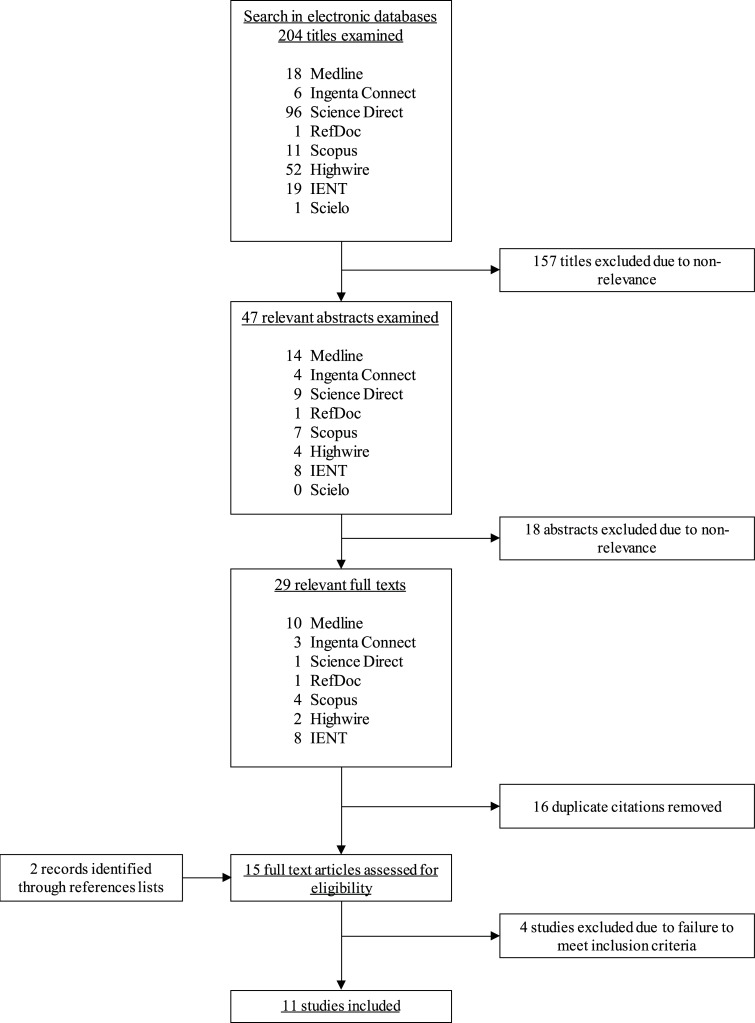
Articles identification and selection flowchart.